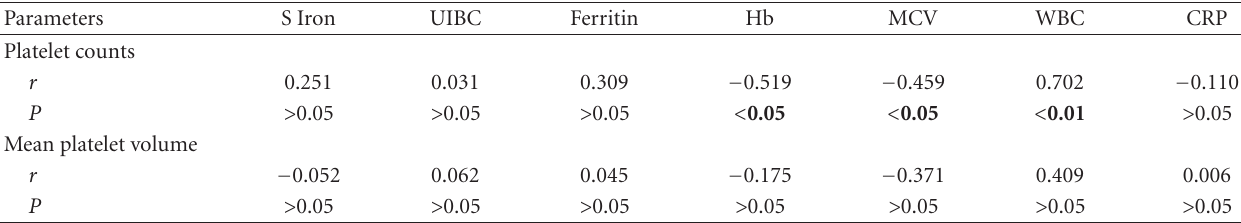
Table 6: The results of Pearson’s correlation test in patients with essential